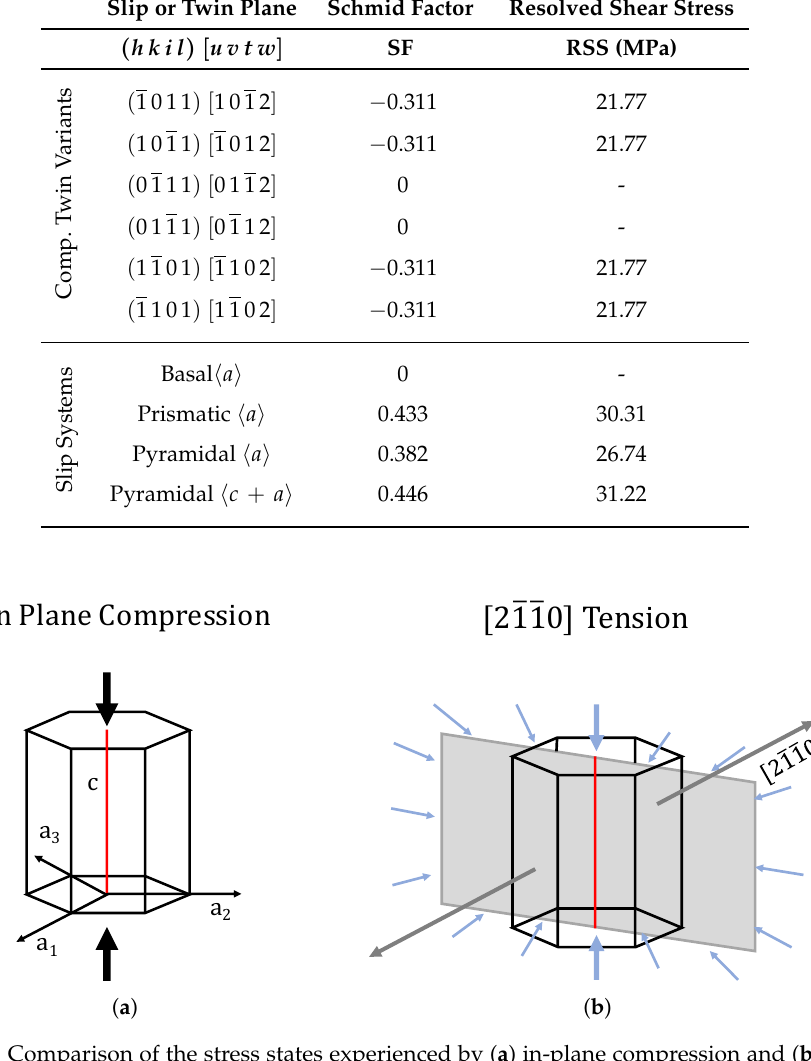
Figure 16. Comparison of the stress states experienced by ( a ) in-plane compression and ( b ) [ 2110 ] tension. The representation of [ 2110 ] tension is simplified to a two-dimensional plane stress representing the plane of maximum compression in an attempt to visualize the complexity of the stress state experienced by contraction of the (cid:104) c (cid:105) -axis due to the Poisson